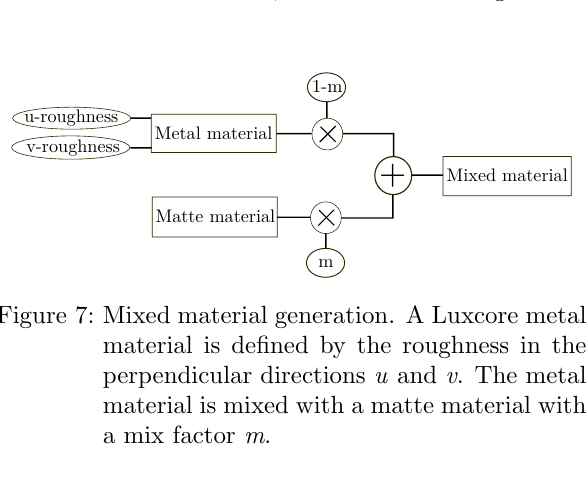
Figure 6: PBR materials require a set of images that defines properties such as color, metalness, surface normals, and microfacet roughness.